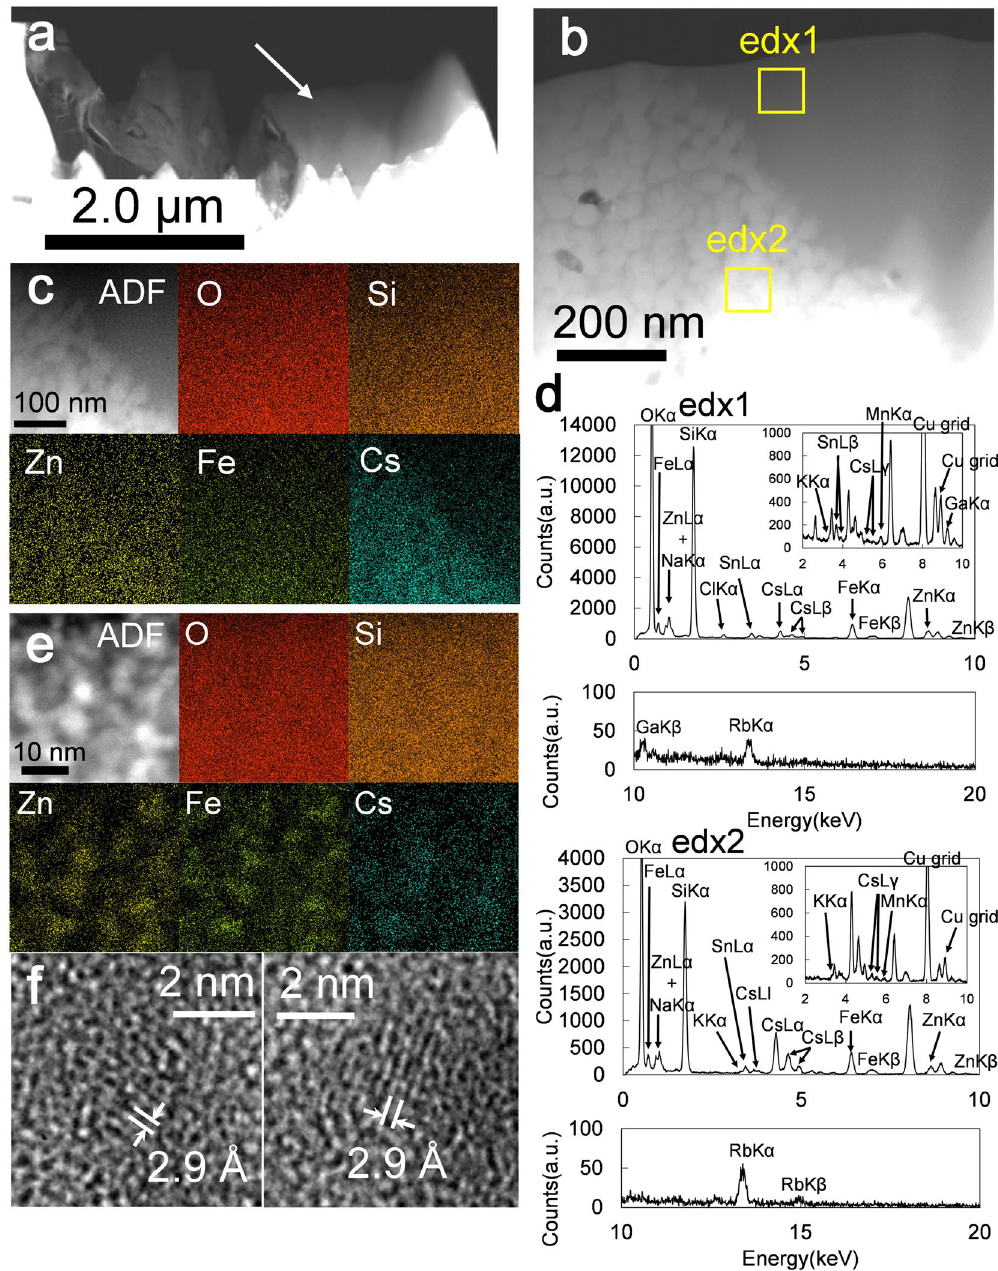
Figure 3. ( a ) A HAADF-STEM image of FIB-TEM specimen of OTZ3-1 CsMP. ( b ) Magnified HAADF-STEM image of the area indicated by the arrow in ( a ). ( c ) HAADF-STEM image (labeled as ADF) and the elemental map of the area displayed in ( b ). ( d ) STEM-EDX spectrums of the area indicated by the yellow square in ( b ). ( e ) Magnified HAADF-STEM image of the dark contrast zone represented as edx1 in ( b ) associated with elemental maps. ( f ) HRTEM image of the Zn–Fe-oxide nanoparticle. The lattice fringe of 2.9 Å corresponds to